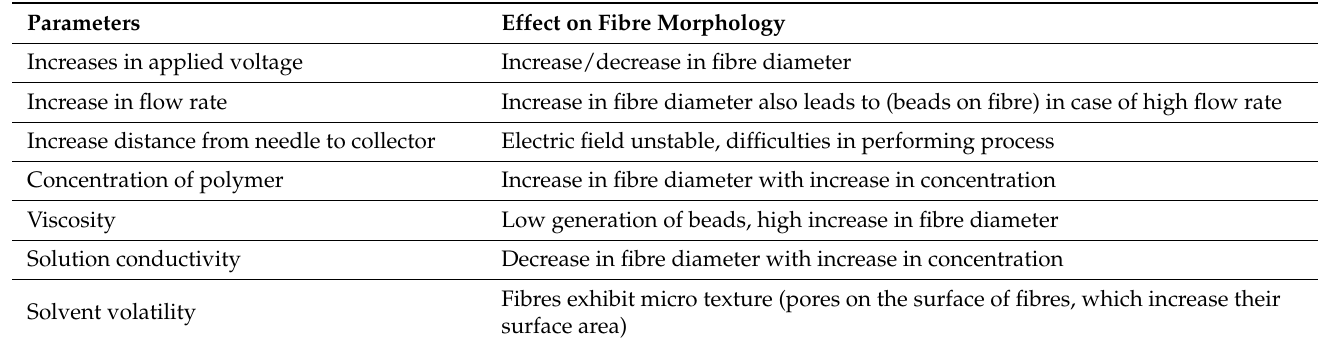
Table 1. Effects of different parameters on the morphology of fibres during the process of electrospin- ning [56].